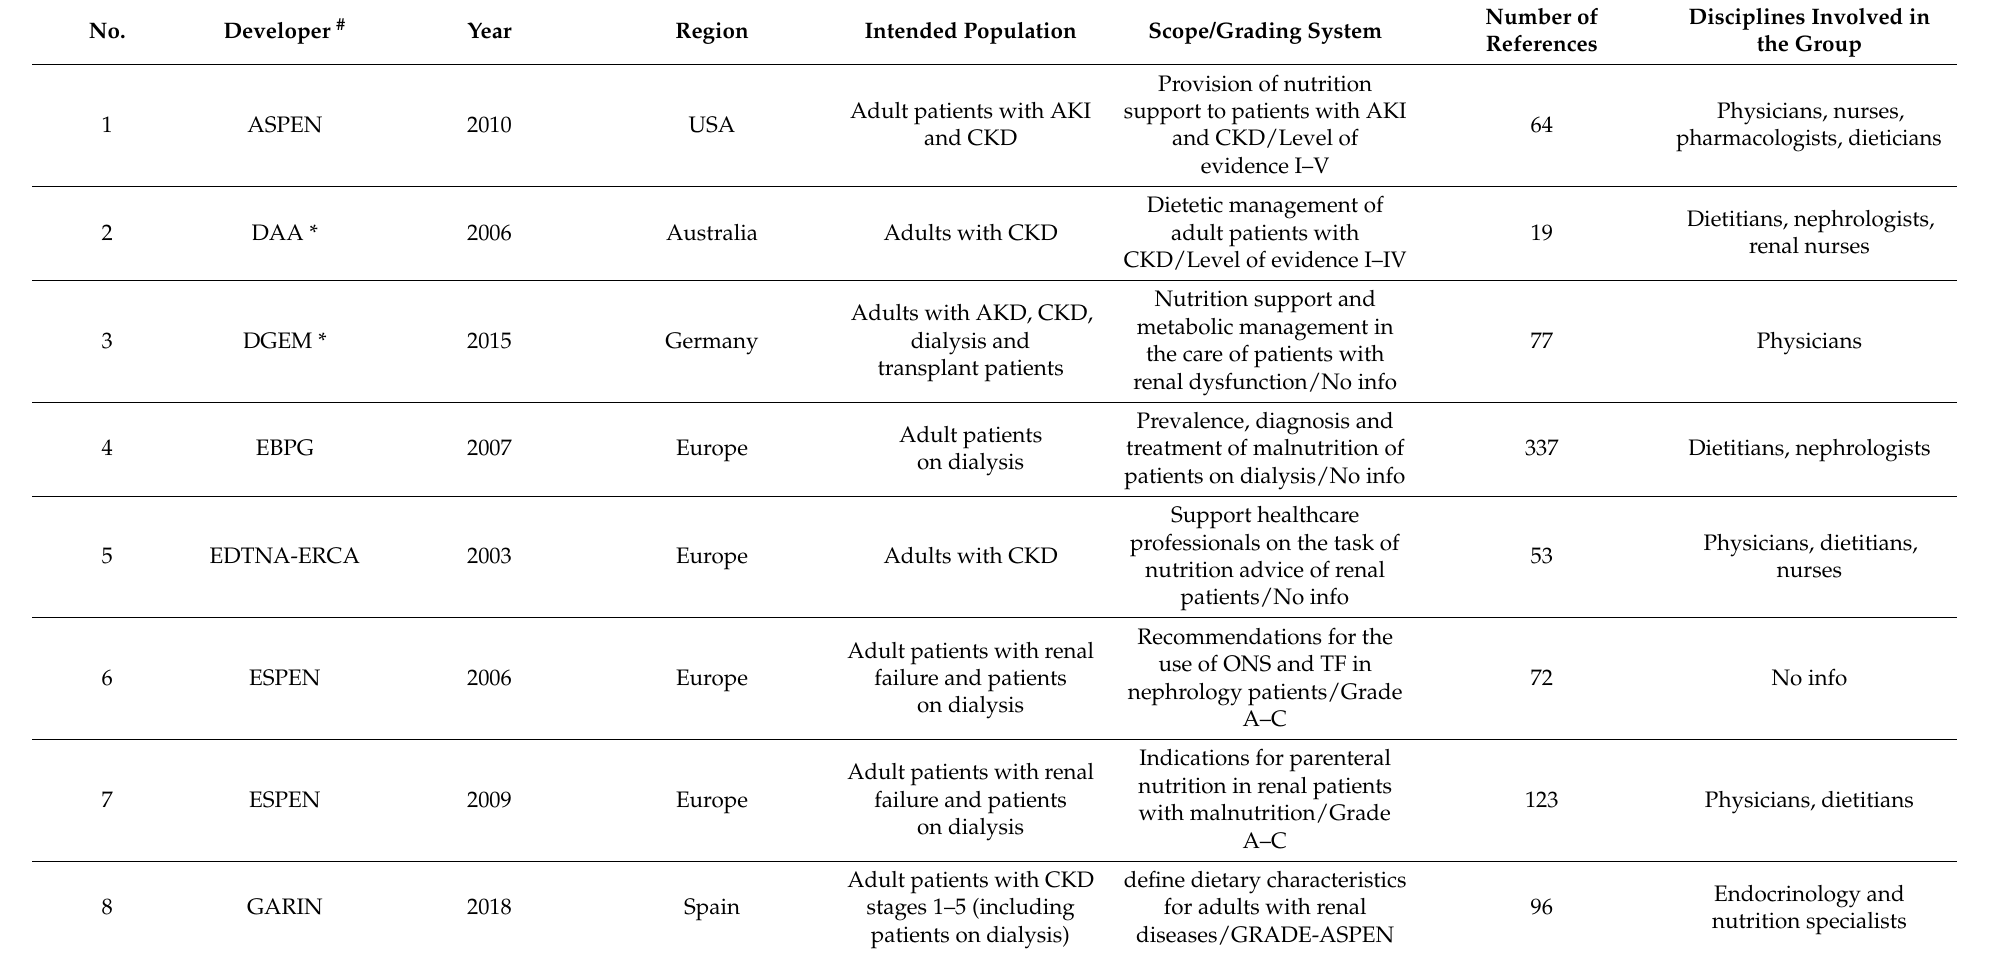
Table 1. Characteristics of included